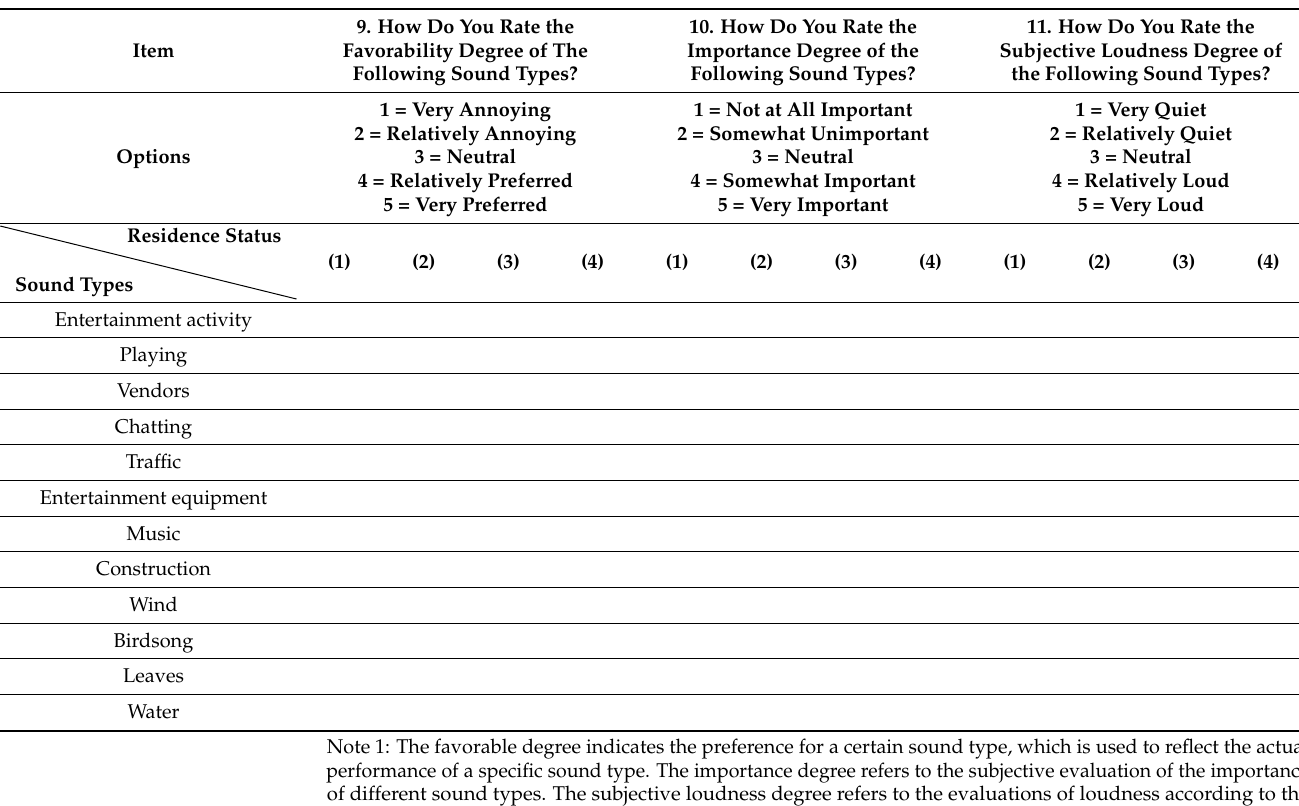
Table A2. Soundscape Perception Evaluation.